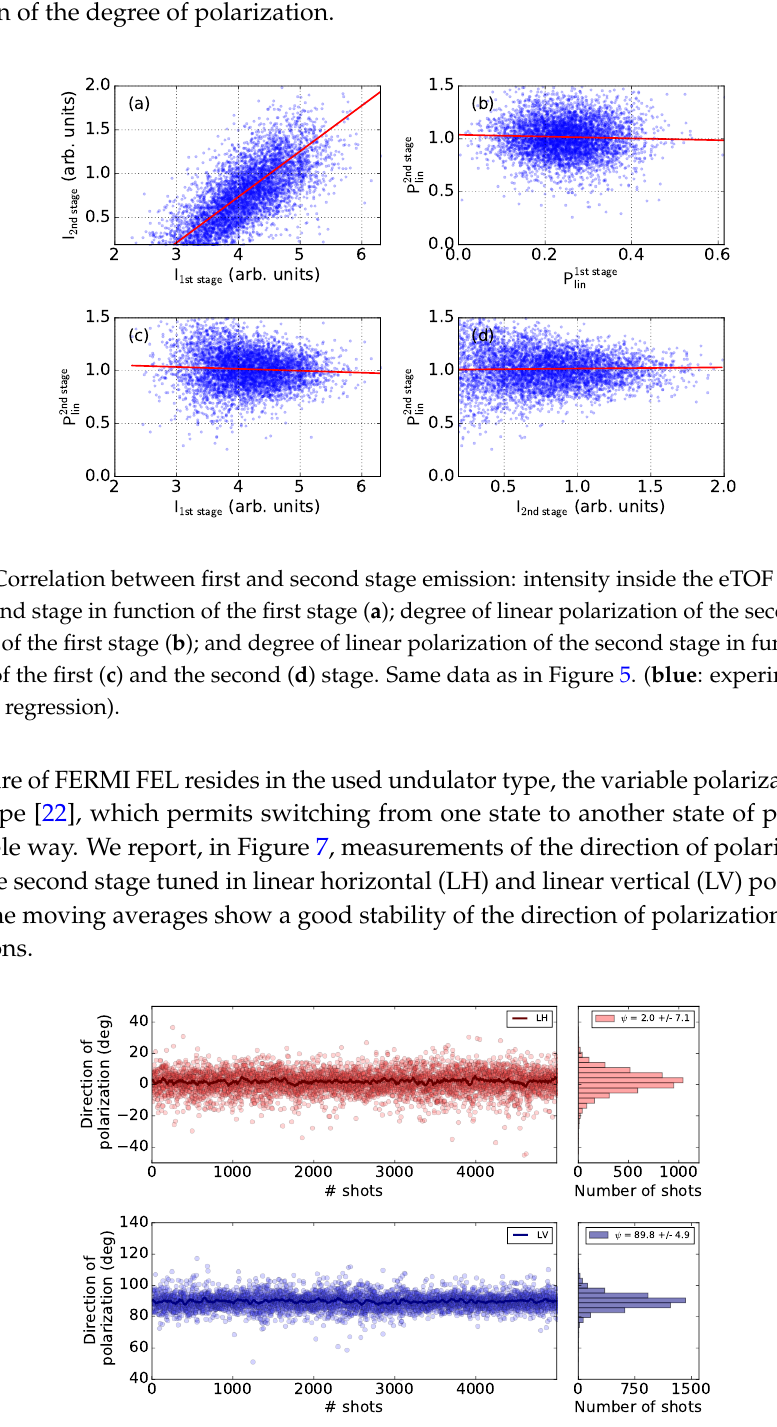
Figure 7. Direction of polarization ψ of the second stage in the case of linear horizontal polarized light ( red ) and linear vertical polarized light ( blue ) at 5.22 nm. The lines represent the moving average over 50